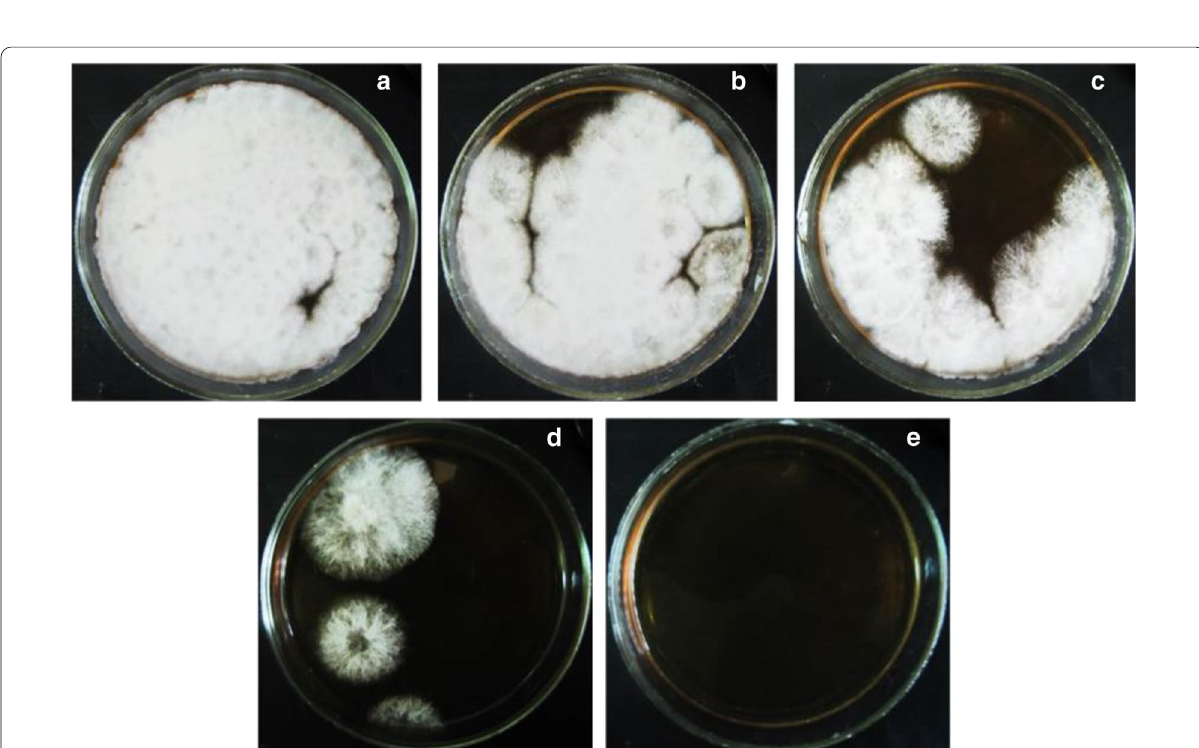
Fig. 7 Regeneration of G. zeae protoplasts exposed to UV irradiation. 10 µL of protoplast suspension (0.5 medium A with sucrose (1 M): without UV exposure ( a ) or exposed to UV for 2 min ( b ), 3 min ( c ), 5 min ( d ), 6 min ( e ) and incubated at 28 °C